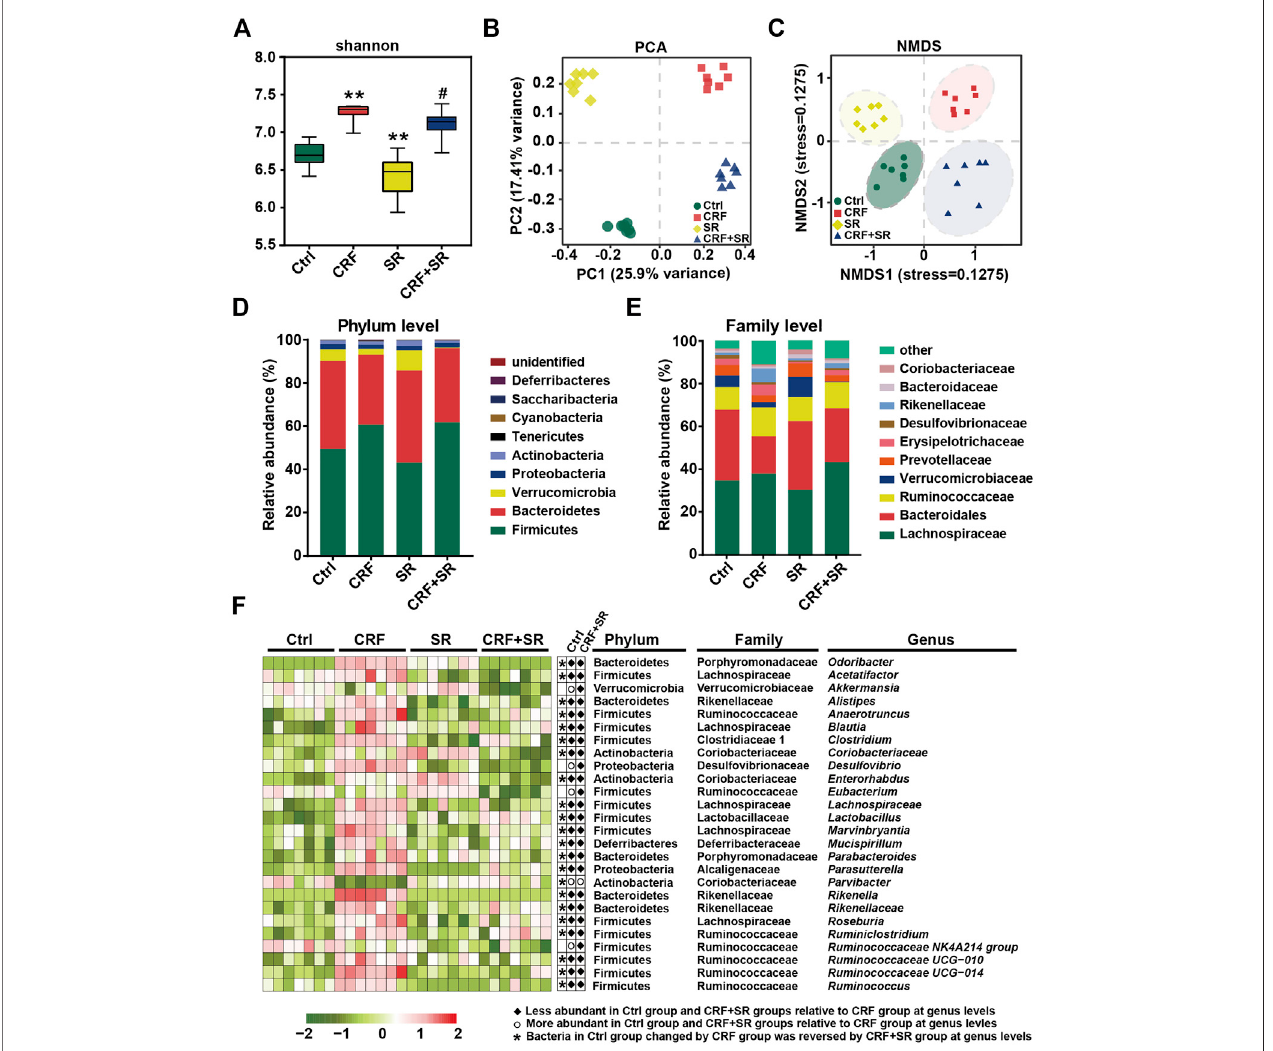
FIGURE6| AmeliorationofgutmicrobiotadysbiosisinCRFmicebySRdecoction. (A) Shannon ’ sdiversityindex. (B) Principalcomponentanalysis(PCA). (C) Non- metric multidimensional scaling (NMDS). (D) Relative abundances at phylum levels. (E) Relative abundances at family levels. (F) Relative abundances of representative bacteria at genus levels. * p < 0.05, ** p < 0.01 vs . Ctrl group; # p < 0.05, ## p < 0.01 vs . CRF